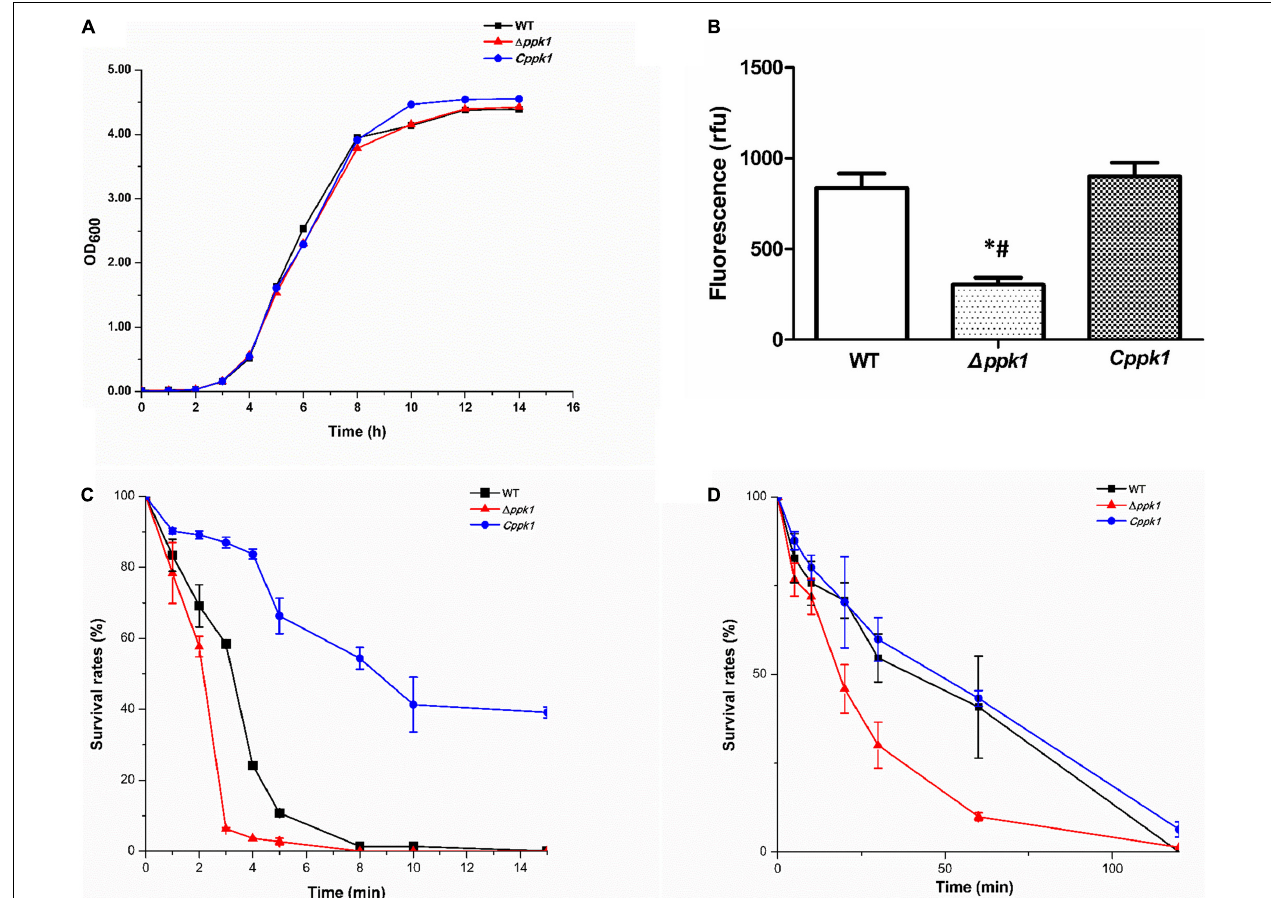
FIGURE 2 | Comparison of the biological characteristics and stringent stress survival assays of the three EHEC O157:H7 strains. (A) Growth curve analysis of the WT, (cid:49) ppk1, and Cppk1 strains. OD: Optical density. (B) The polyP levels of WT, (cid:49) ppk1, and Cppk1 strains. Error bars indicate standard deviations. *, p < 0.05 as compared with the WT strain; #, p < 0.05 as compared with the Cppk1 strain. (C) The survival rates of WT, (cid:49) ppk1, and Cppk1 strains after exposure to 55 ◦ C at different time points. (D) The survival rates of WT, (cid:49) ppk1, and Cppk1 strains under acid stress at pH 2.0 in liquid LB at different time points.